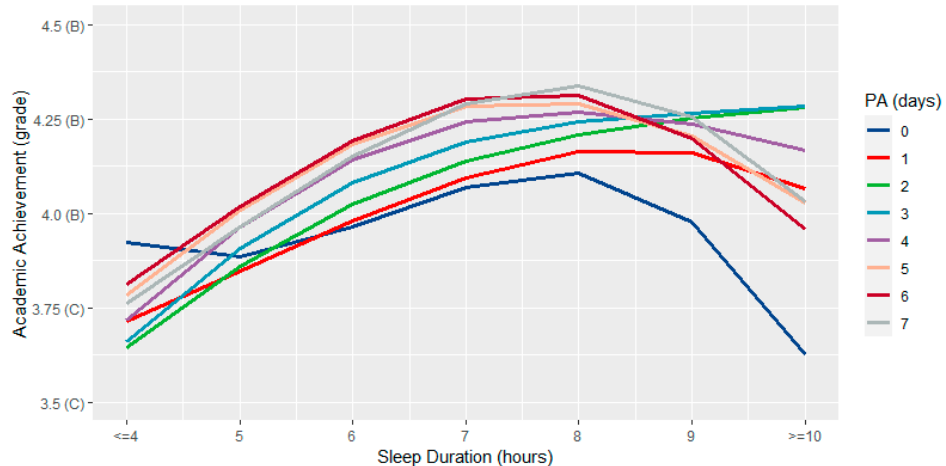
Figure 3. Interactive association between physical activity and sleep in relation to academic achieve- ment.